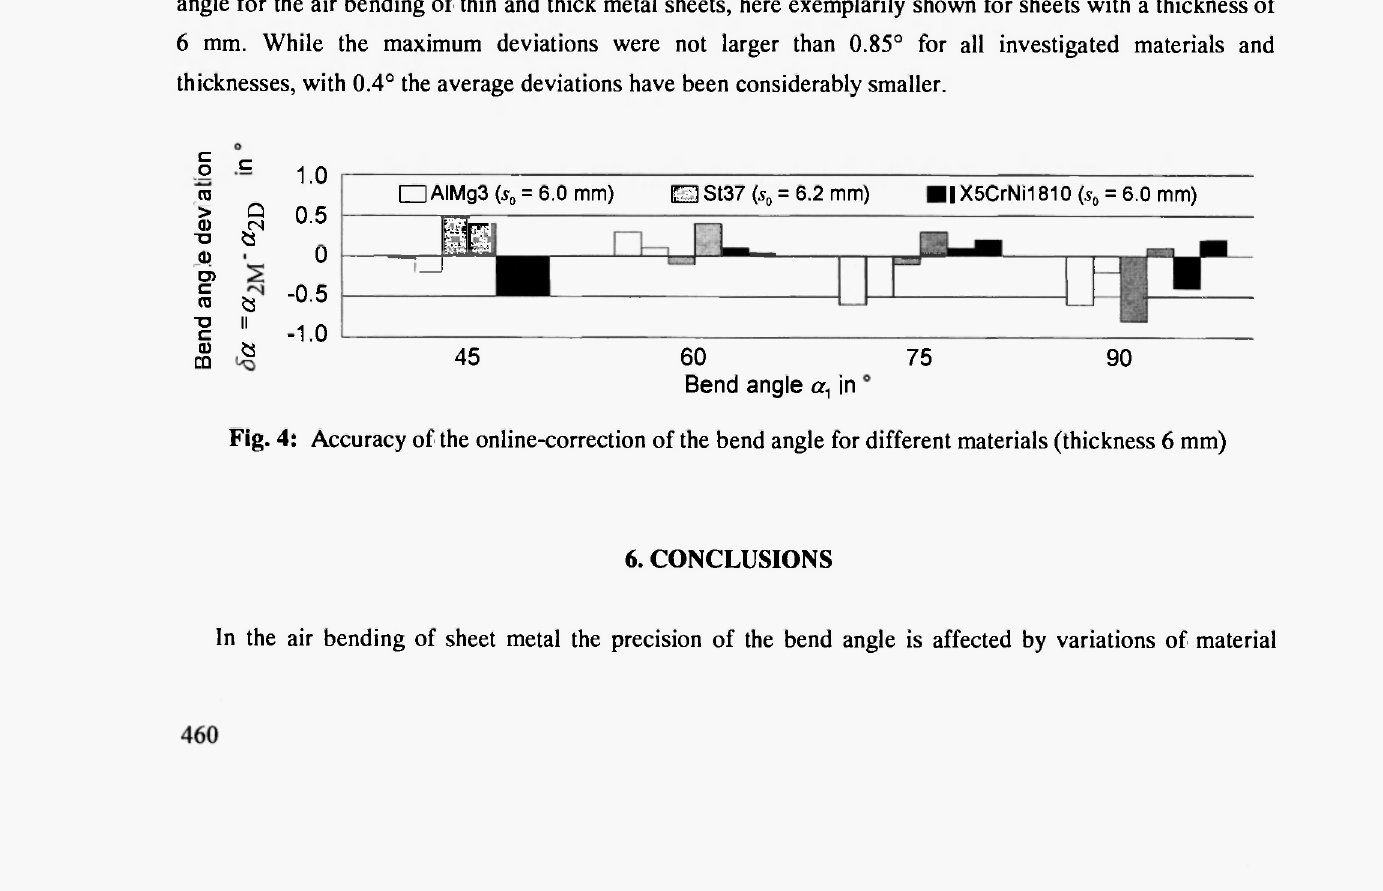
Fig. 4: Accuracy of the online-correction of the bend angle for different materials (thickness 6